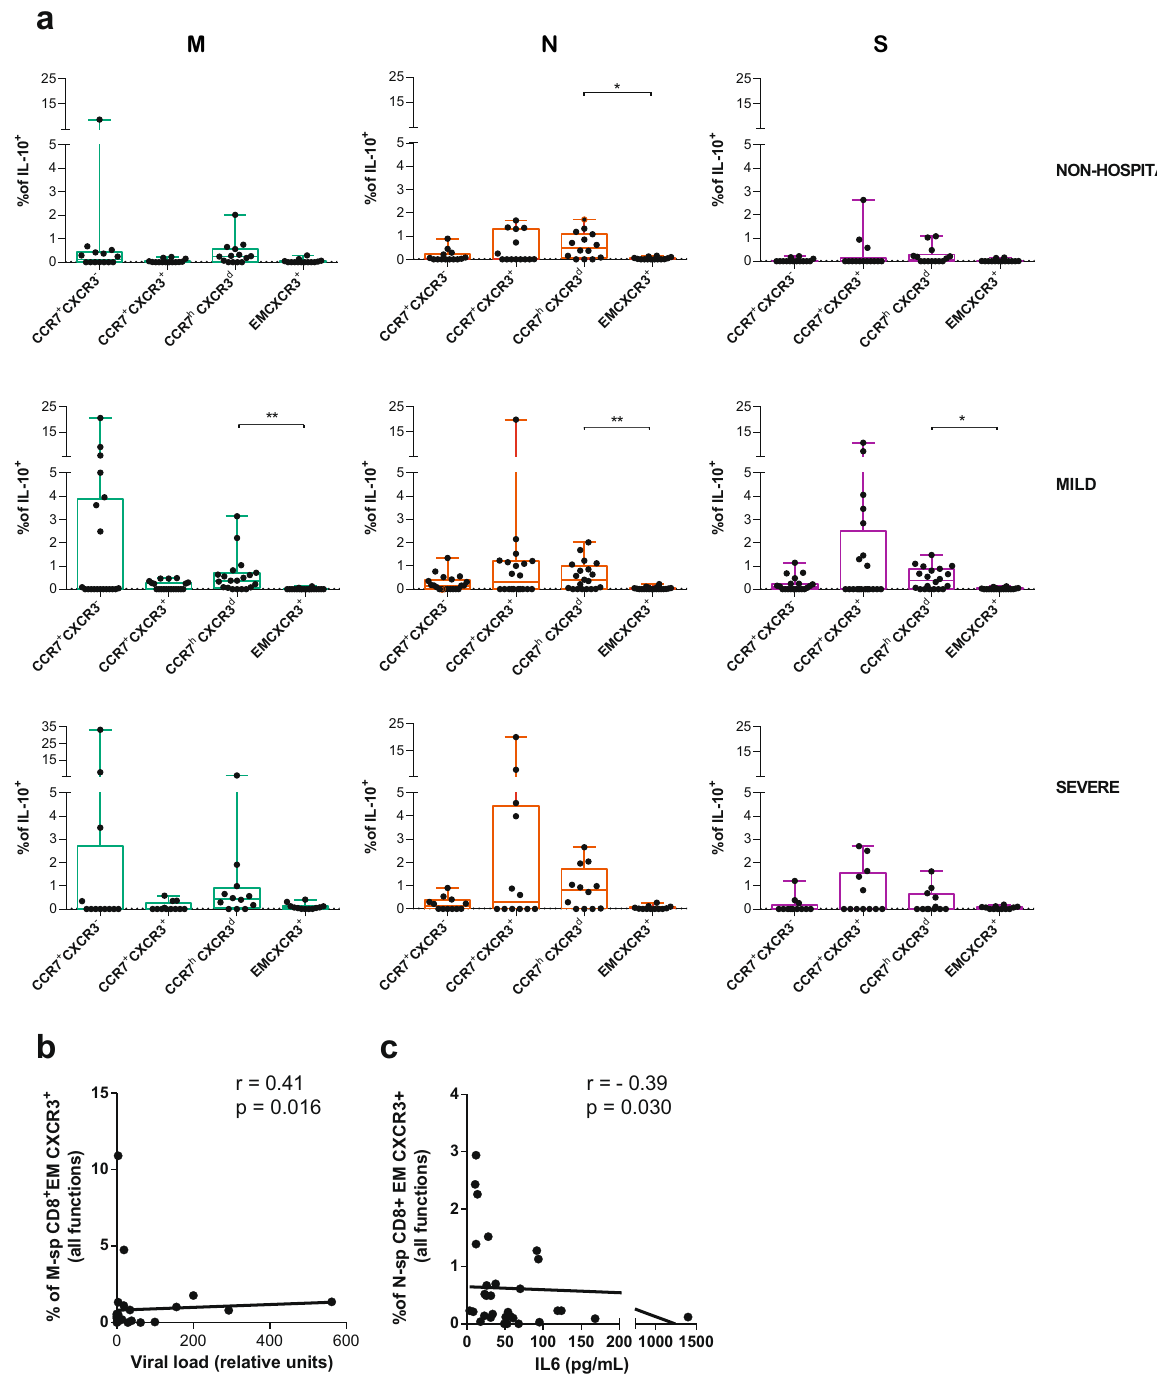
Fig. 4 IL-10 expression in acute SARS-CoV-2-speci fi c CD8 + T cell subsets. a Net frequency of interleukin (IL)-10 expression in CCR7 + CXCR3 − , CCR7 + CXCR3 + , CCR7 h CXCR3 d , and EM CXCR3 + subsets within CD8 + T cells after stimulation with any of the three viral proteins (membrane (M), nucleocapsid (N), and spike (S) proteins). Data are shown as median and upper range, where each dot represents an individual patient for each group (nonhospitalized n = 14; mild n = 20, and severe n = 12). Statistical comparisons were performed using Kruskal – Wallis rank-sum test with Dunn ’ s multiple comparison test (two-sided): nonhospitalized (N, p = 0.041) and mild (M, p = 0.003; N, p = 0.007 and S, p = 0.042). b , c Correlation between CD8 + EM CXCR3 + T cells responding with any function (added net response for interferon (IFN) γ , CD107a, IL-4 and IL-10) against M peptides and viral load ( b ) and against N peptides and baseline IL-6 levels ( c ). Two-tailed spearman rank correlation ( n = 33 for viral load and n = 46 for